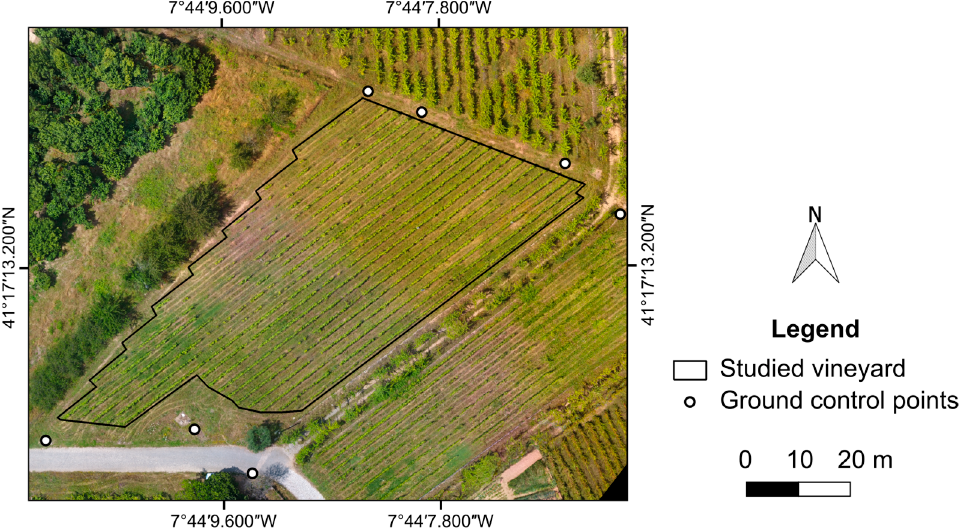
Figure 1. General overview of the studied area delimited by a polygon. Coordinates in WGS84 (EPSG:4326).